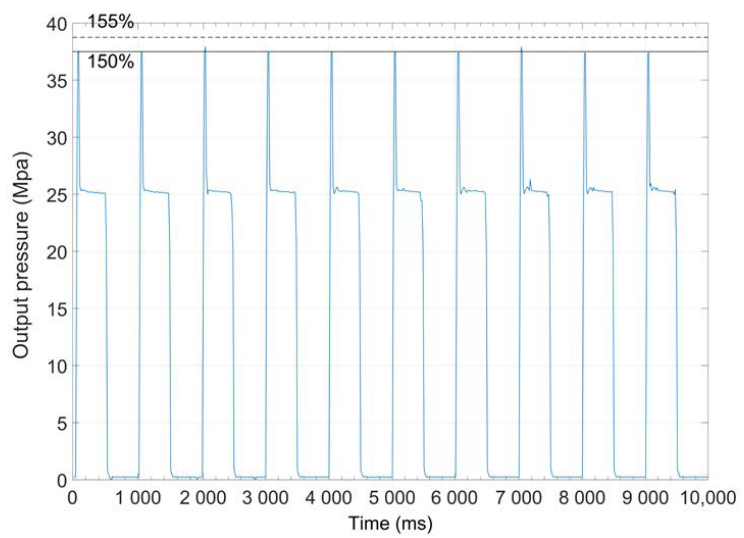
Figure 11. Repeatability results for 10